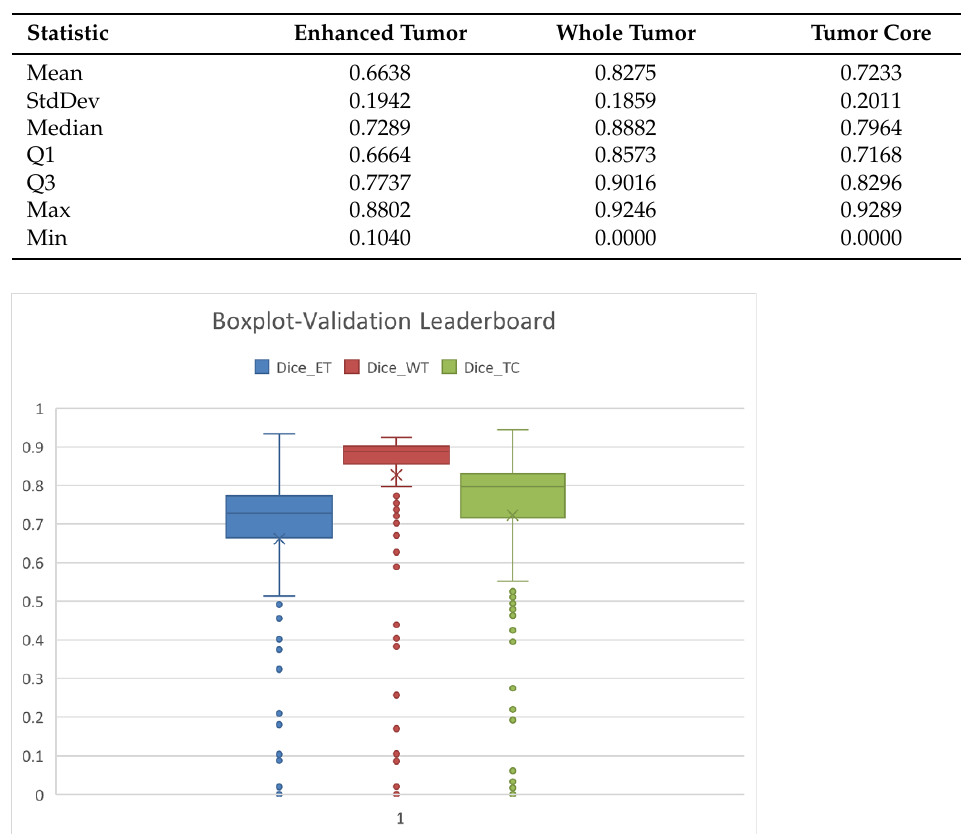
Table 9. Dice on the BraTS 2020 Leaderboard.